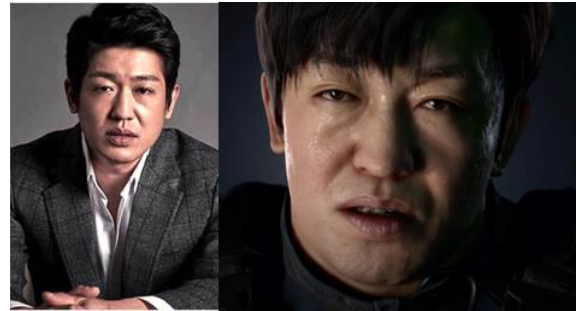
Figure 4. Heo Seong-tae. (L—Human, R—Digital Human).